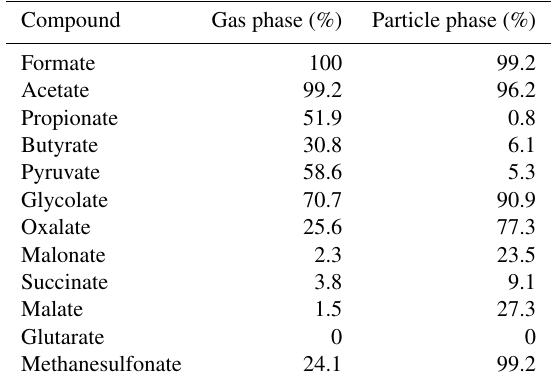
Table 6. Data coverage for the organic species measured in the gas and particle phases from 3 to 14 May 2017 during instrument up- time periods shown for data above the LOD.